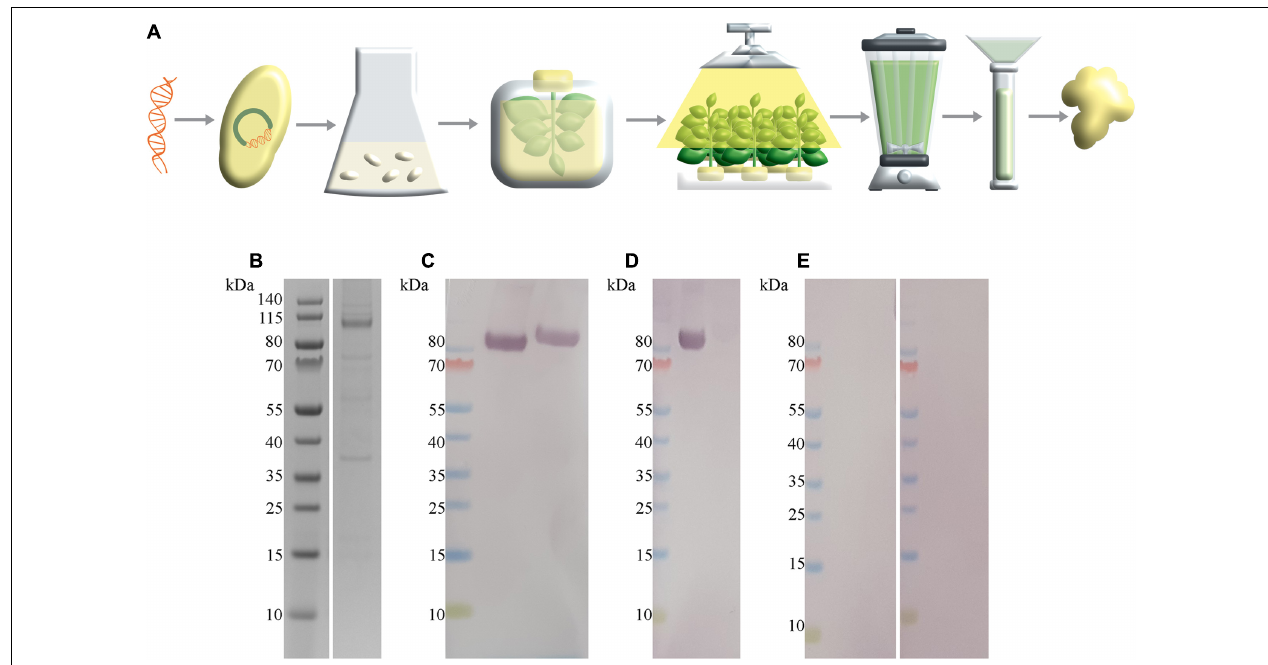
FIGURE 2 | SARS-CoV-2 S1-His antigen production workflow with corresponding size and functionality analysis. (A) Schematic overview about plant-based transient recombinant antigen production. SARS-CoV-2 S1 protein encoding DNA was transformed into Agrobacterium tumefaciens . Then, N. benthamiana plants were vacuum infiltrated with A. tumefaciens . After cultivation of transiently infiltrated plants for 5 days, leaves were harvested, followed by protein extracted via juicing and purification of the target protein using immobilized metal affinity chromatography (IMAC) purification strategy. (B) Sodium dodecyl sulfate–polyacrylamide gel electrophoresis (SDS-PAGE) of IMAC-purified SARS-CoV-2 S1-His antigen recombinant produced in N. benthamiana with expected size of 80 kDa, under reducing conditions. In total, approximately 328 ng SARS-CoV-2 S1 protein was loaded. (C) Western blot analysis of SARS-CoV-2 S1-His protein, probed with anti-His antibody under non-reducing conditions (left) and reducing conditions (right). (D) Western blot analysis of 2 µ g SARS-CoV-2 S1-His protein probed with patient serum previously tested positive with Liaison SARS-CoV-2 S1/S2 IgG assay and (E) each probed with a patient sera tested negative for the occurrence of SARS-CoV-2-specific